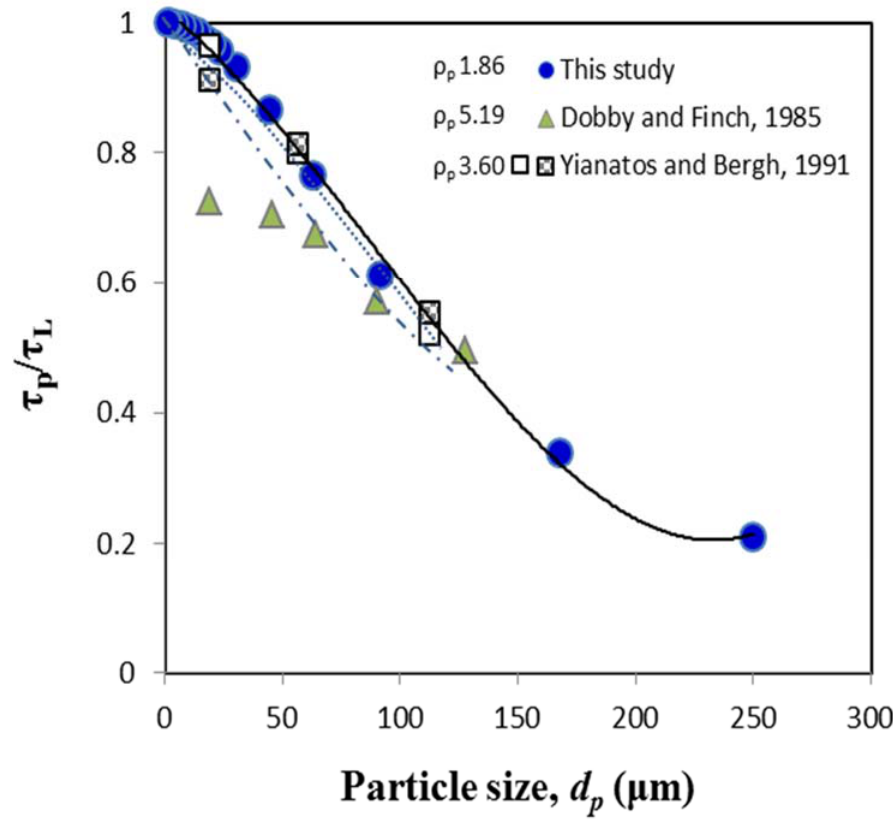
Figure 4. Ratio of particle mean residence time to liquid mean residence time ( τ p / τ L ) versus particle size.